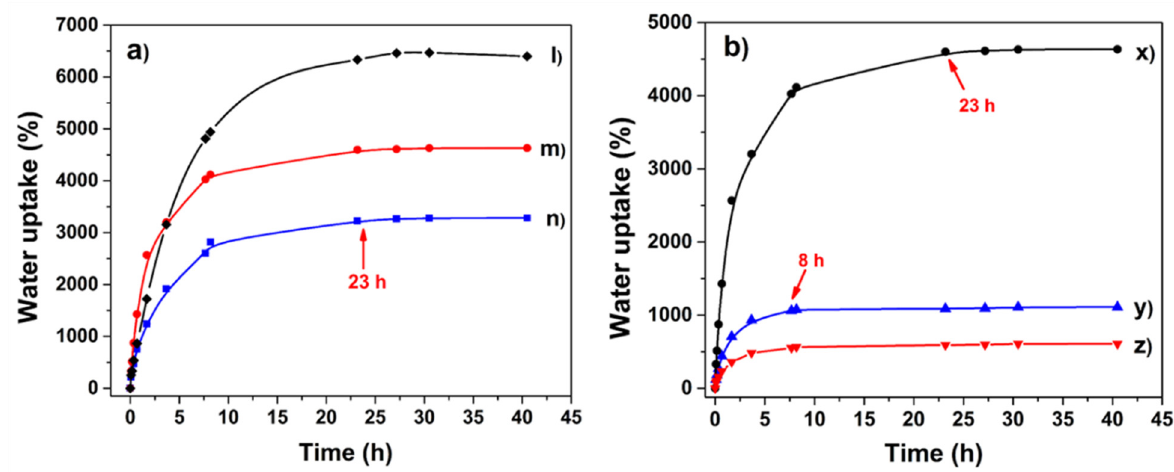
Figure 8. ( a ). Swelling profile of hydrogels obtained at different irradiation dose (l) 15, (m) 20, and (n) 25 kGy, respectively, using 1 mL of AAc. ( b ). Swelling profile of hydrogels as a function of AAc amount (x) 1 mL, (y) 1.5 mL, and (z) 2 mL, irradiated at 20 kGy.